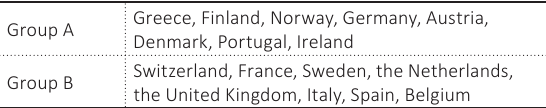
Table 2. Countries of each group